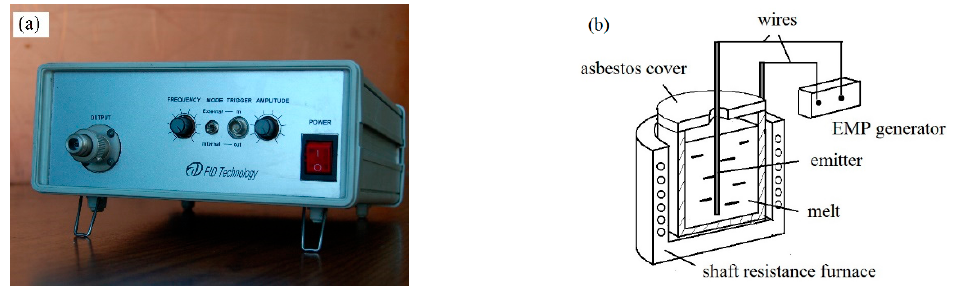
Figure 1. Electromagnetic pulse generator ( a ) and installation scheme for processing melts ( b ). EMP: electromagnetic pulse.